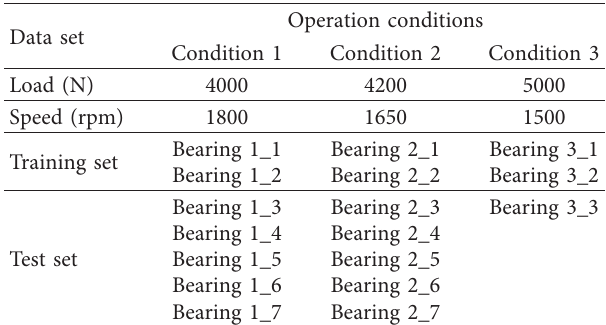
Figure 7: The PRONOSTIA platform for bearing accelerated degradation tests. Table 1: Datasets of IEEE PHM 2012 prognostic challenge.